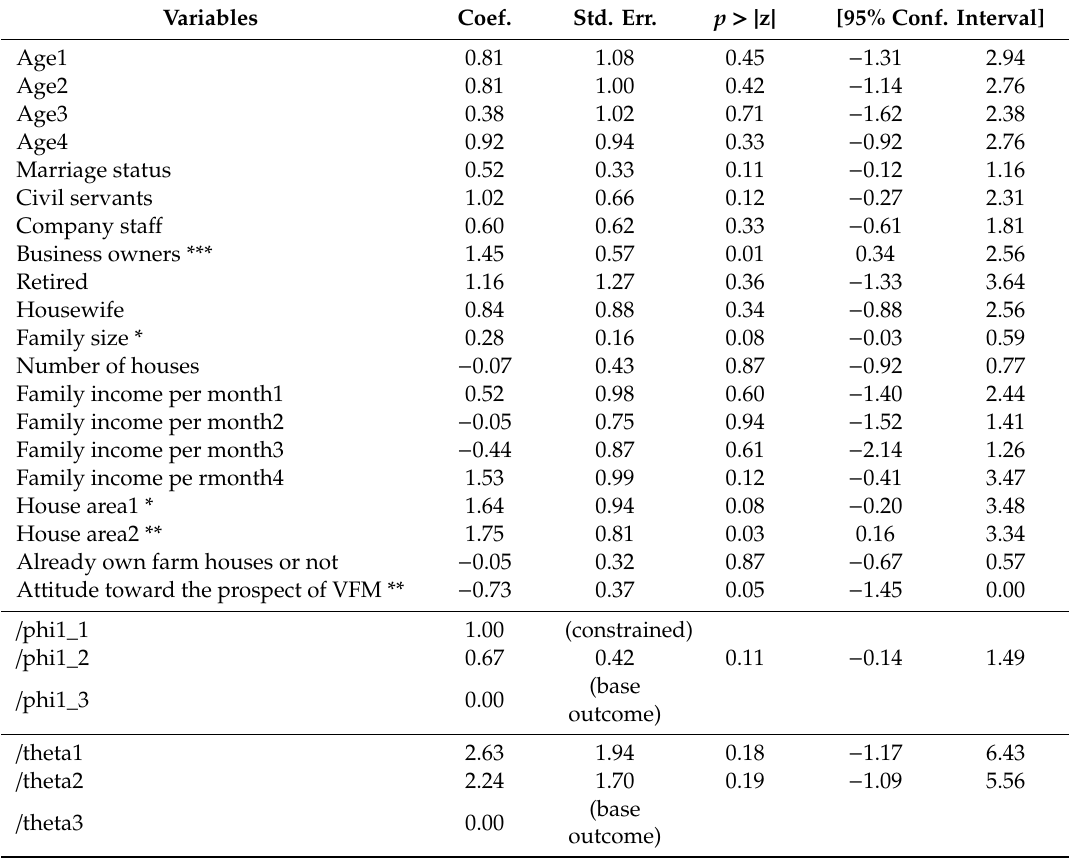
Table 10. The estimation results of urban residents’